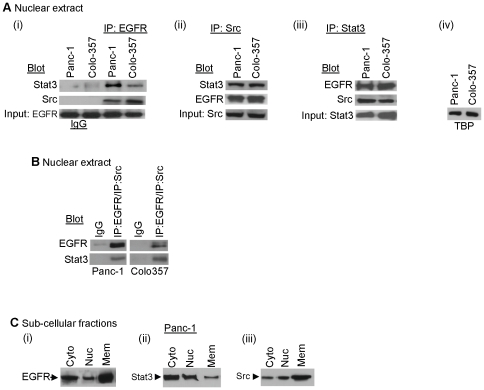
Co-immunoprecipitation with immunoblotting analysis of EGFR, Src and Stat3 complex in the nucleus and the sub-cellular distribution of EGFR, Src and Stat3.(A and B) Immunoblotting analyses of immunecomplexes of EGFR (IP:EGFR), Src (IP:Src), Stat3 (IP:Stat3), EGFR/Src (IP:EGFR/IP:Src), or of non-specific IgG non-immuneprecpitate prepared from nuclear extracts of Panc-1 or Colo-357 cells and probing for Stat3, EGFR, Src, or the Tata-binding protein (TBP); and (C), immunoblotting analysis of membrane (mem) and cytosolic (cyto) fractions and of nuclear (nuc) extracts from Panc-1 cells probing for (i) EGFR, (ii) Stat3 and (iii) Src. Bands corresponding to proteins in gel are shown; input: except where indicated, represents the immunoblotting for the respective immunoprecipitated protein in the same amount of nuclear extract used in the assay; IP:EGFR/IP:Src, sequential immunoprecipitation with anti-EGFR and then anti-Src antibody; Data are representative of 3 independent studies.